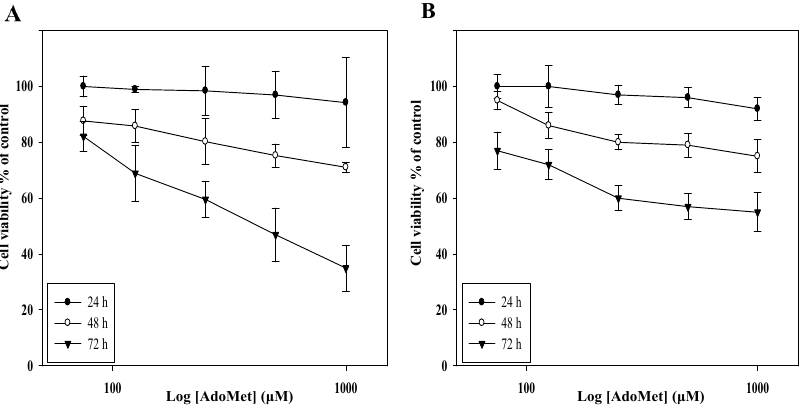
Figure 1. Effect of AdoMet on colorectal cancer cell viability. HCT 116 p53+/+ ( A ) and LoVo ( B ) cells were treated or not (control) with increasing amounts of AdoMet (72–1000 µ M) for 24, 48 and 72h, then cell viability was assessed by MTT assay. Data represent the average of three independent experiments; error bars depict the standard deviation